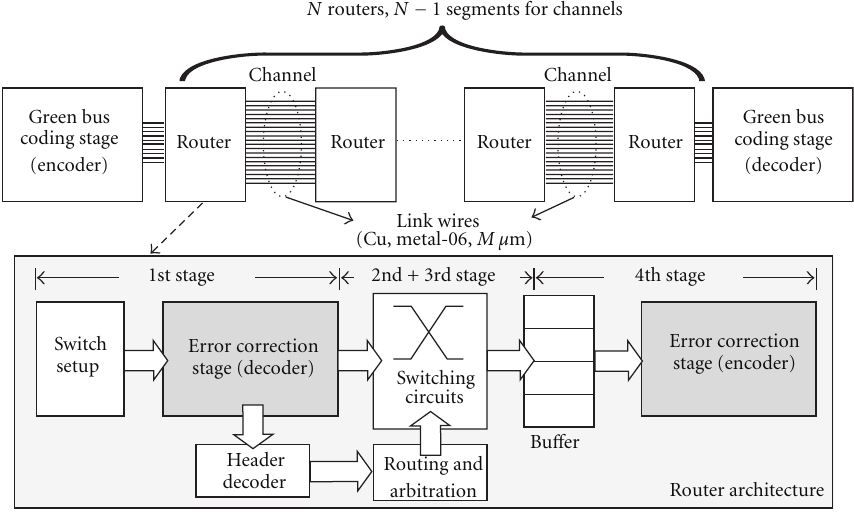
Figure 16: Simulation environment setup with di ff erent number of routers ( N ) and di ff erent lengths ( M ) of link wires.